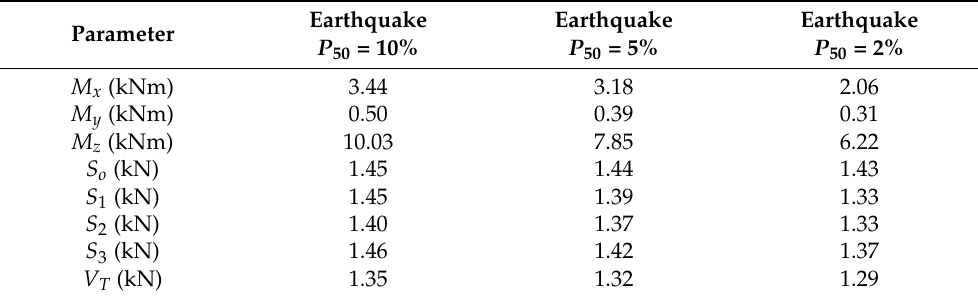
Table 11. KPI E 2 evaluated for the internal forces for the three values of the seismic actions.